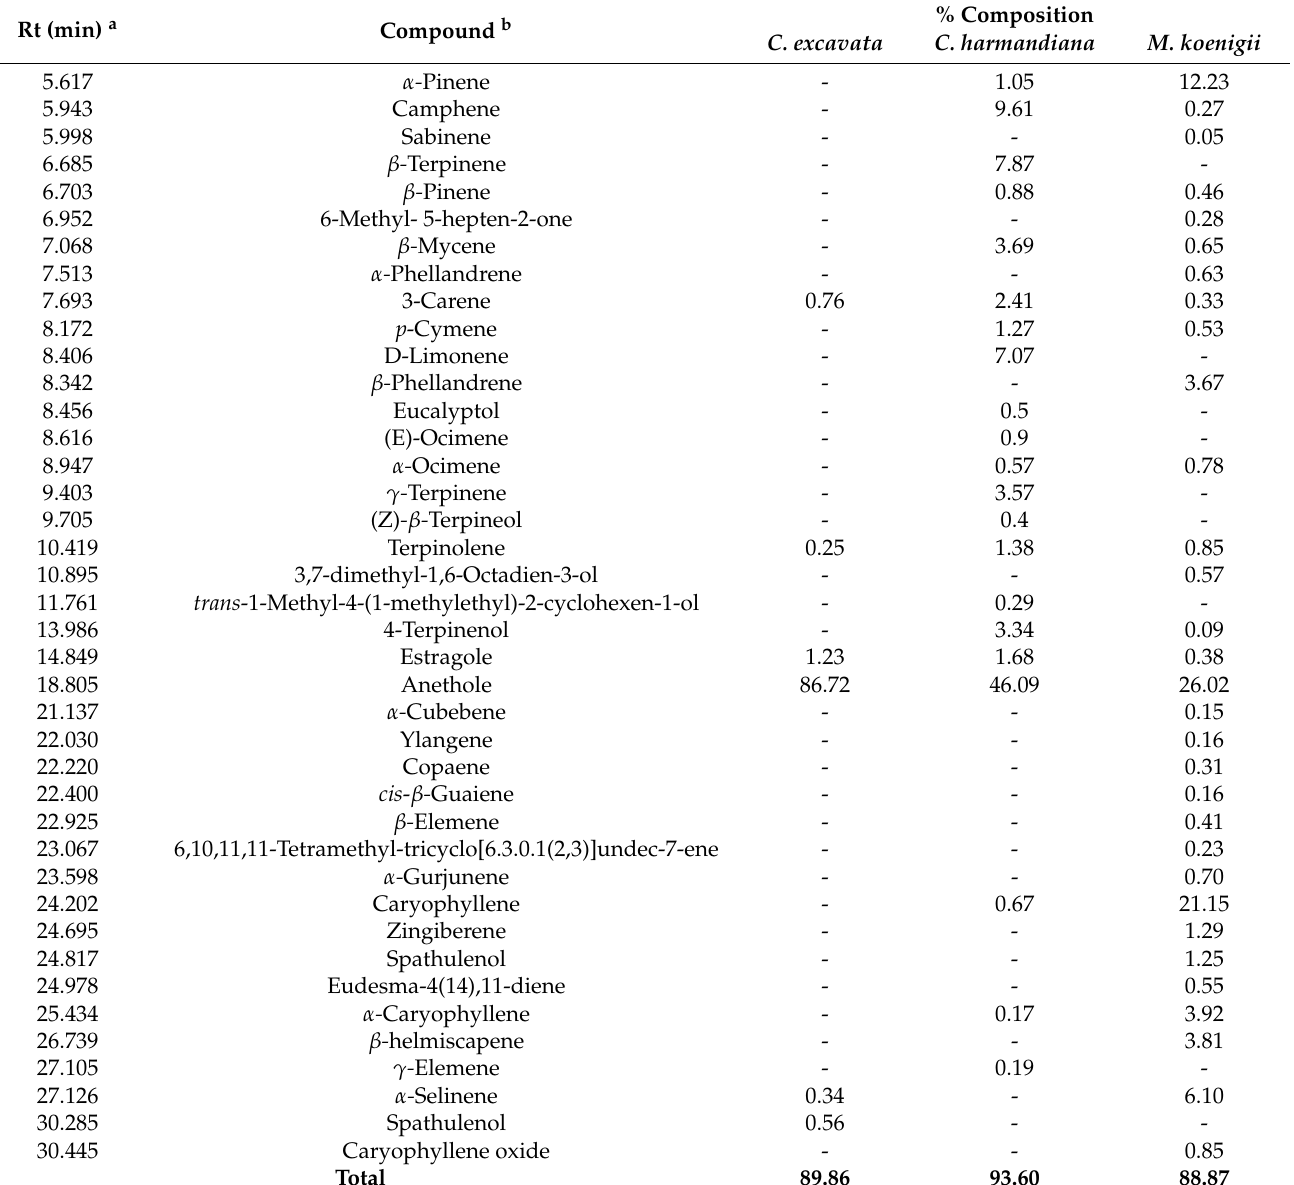
Table 1. Chemical composition of Clausena excavata , Clausena harmandiana and Murraya koenigii leaves essential